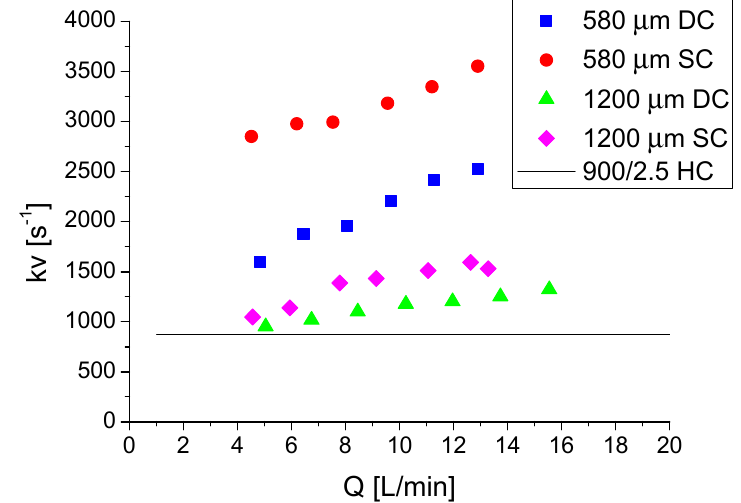
Figure 9. Volumetric mass transfer coefficients for the prepared samples as a function of actualized flow rates: DC—dip coated samples, SC—spin coated samples, HC square channel honeycomb.